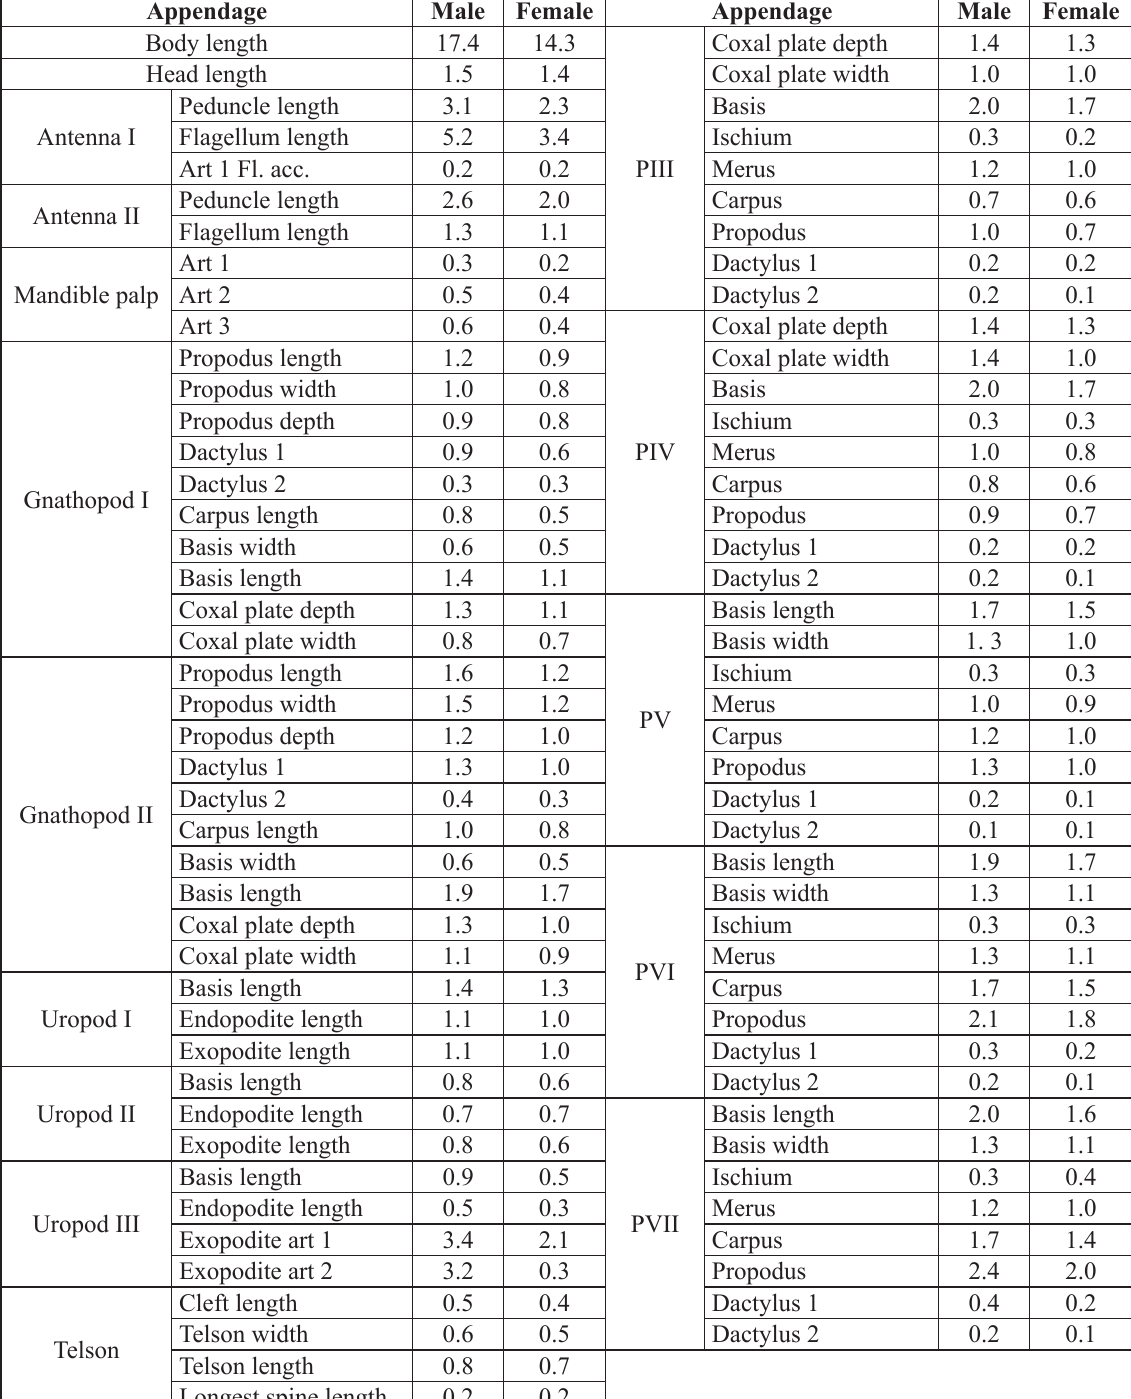
European Journal of Taxonomy 164: 1–28 Table 1. Measurements in mm of the various appendages of male and female Niphargus dancaui sp. nov. sampled from a well located on Aleea Cetăţii 1 in the town of Mangalia (SE Romania).